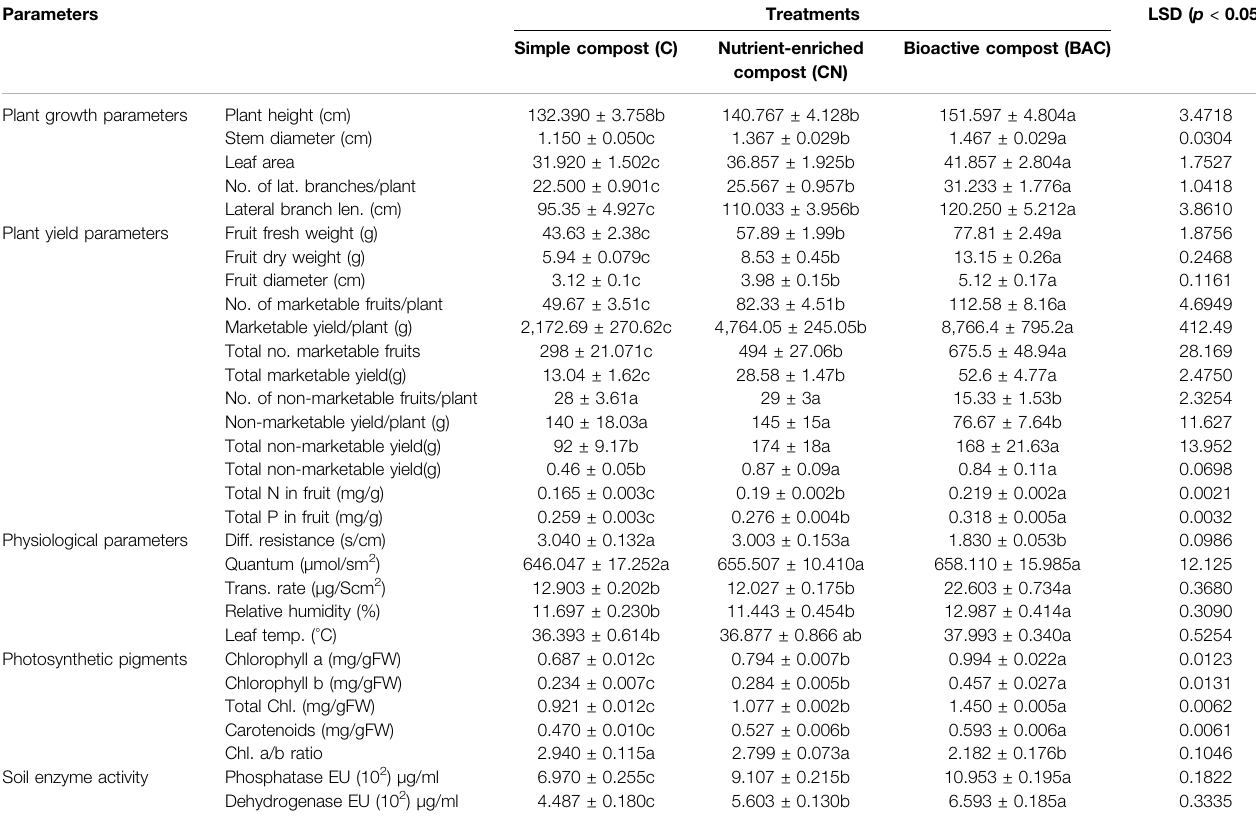
TABLE 7 | Effect of bioactive compost on growth, yield, physiological and photosynthetic pigments of tomatoes grown in small tunnel, and post-harvest activity analysis of enzymes in soil (2 years averaged data).